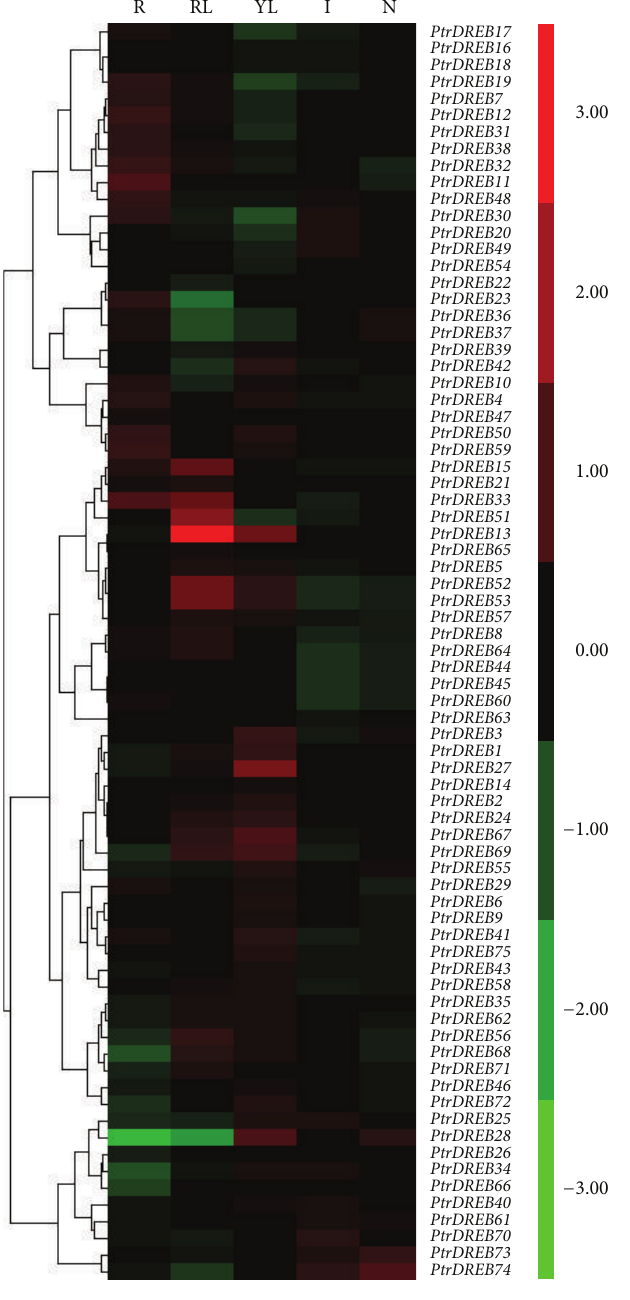
Figure 6: Expression profiles of Populus DREB genes across different tissues. Heat map showing hierarchical clustering of 75 PtrDREB genes across various tissues analyzed. The Affymetrix microarray data were obtained from NCBI Gene Expression Omnibus (GEO) database under the series accession number GSE16422. ML: mature leaf; YL: young leaf; R: root; I: internodes; N: nodes. Color scale represents log2 expression values, green represents low level, and red indicates high level of transcript